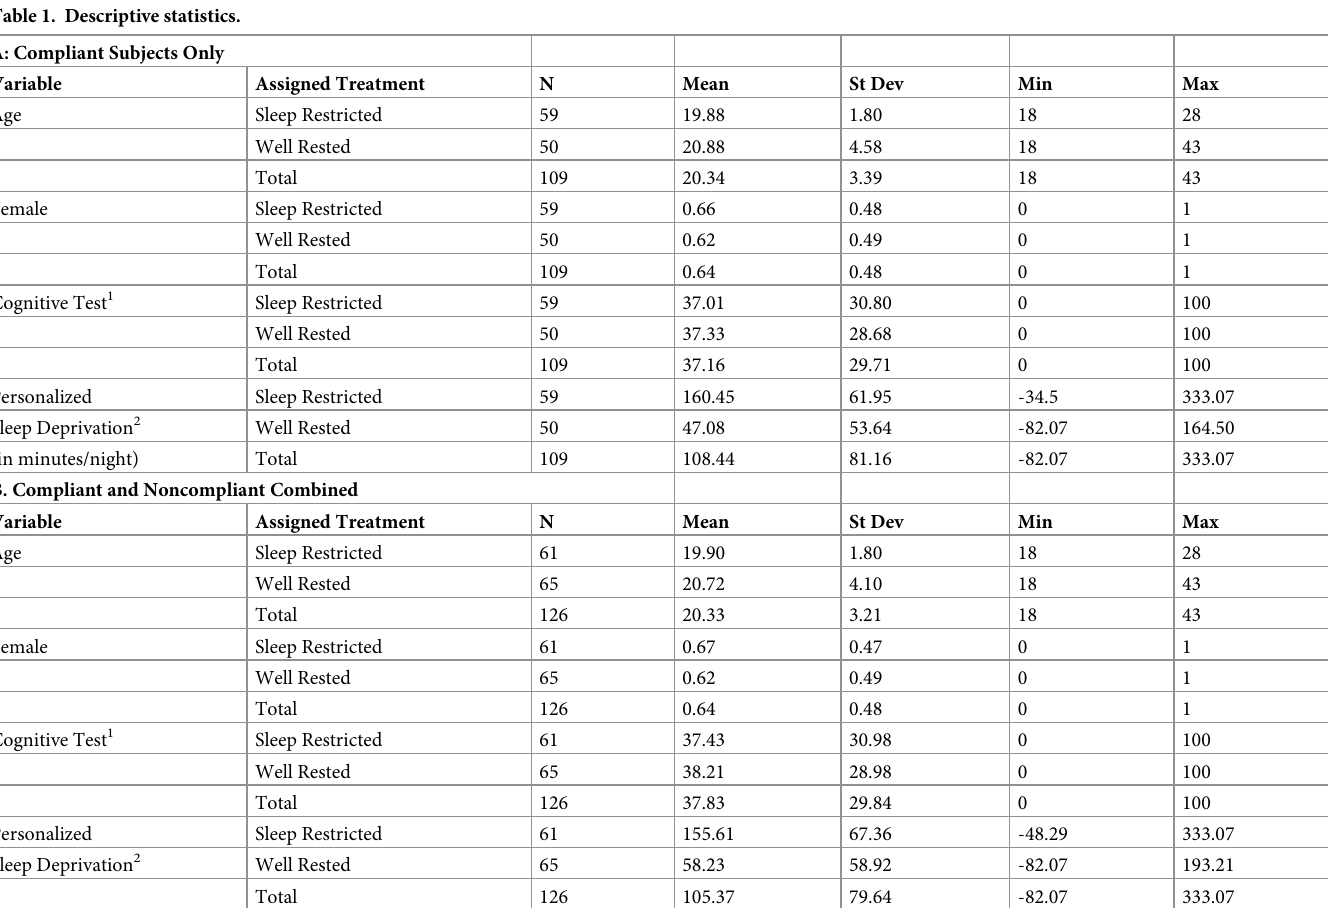
Table 1. Descriptive